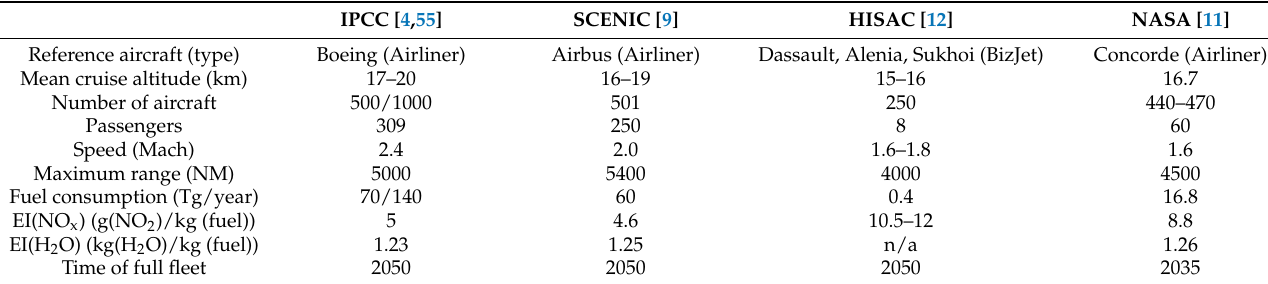
Table 1. Overview of supersonic